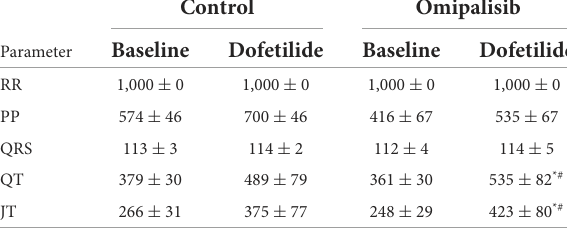
TABLE 1 Electrophysiological parameters of anesthetized dogs ( n before treatment (control) and after 1 mg/kg omipalisib treatment for once a